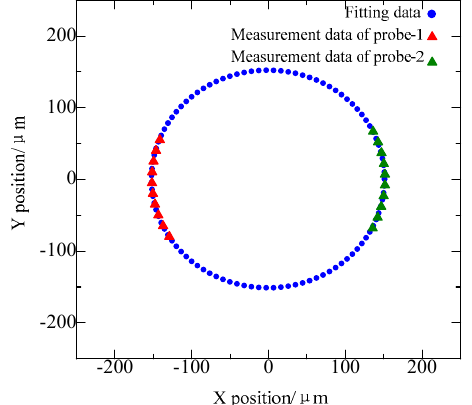
Figure 12. Measurement data of two probes.